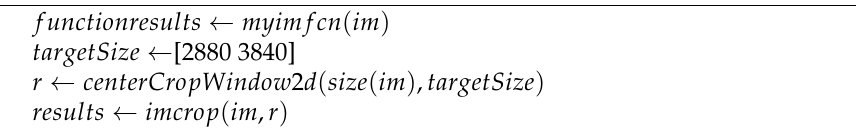
Algorithm A2: Function to crop the RGB images in Matlab